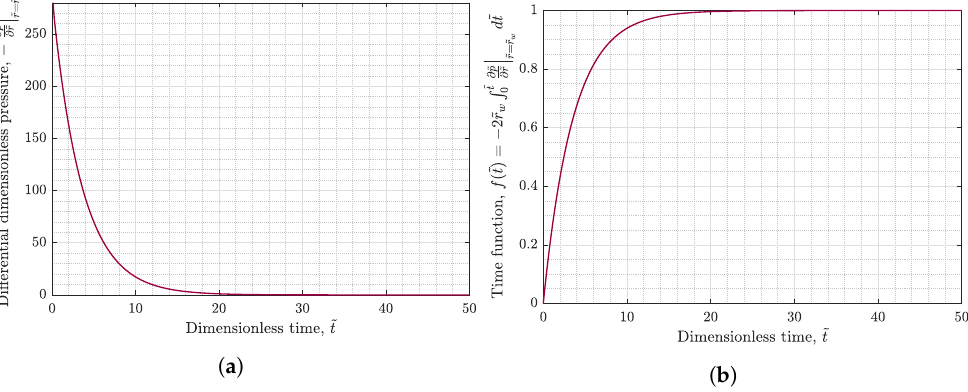
Figure A4. ( a ) Differential dimensionless pressure at the wellbore; ( b ) Time function, f ( ˜ t ) , for simulation result in ft Figure A3 ( r e = 500).